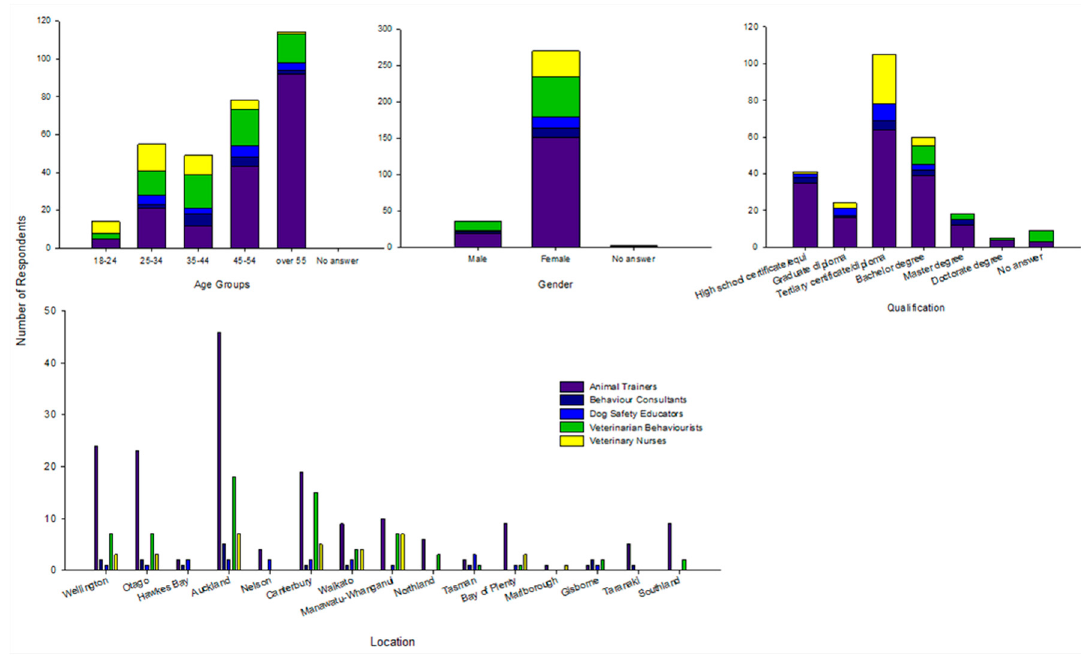
Figure 2. Demographic data across all professional groups (animal trainers, behaviour consultants, dog safety educators, veterinarians and veterinary nurses) describing age, gender, qualification and location.